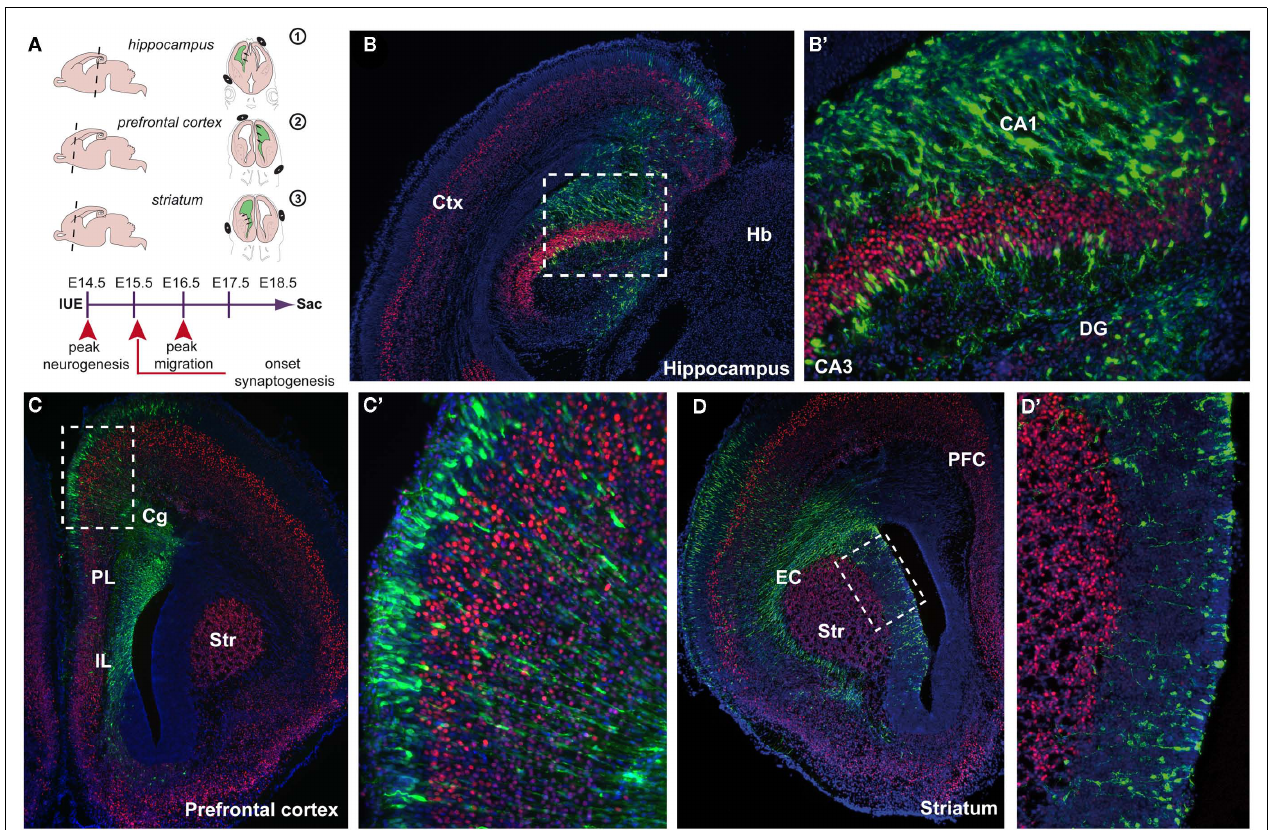
construct CMV–YFP–N1 (green) is electroporated into the hippocampal anlage enlarged in (B (cid:2) ) (boxed area), counterstained with the layerV marker Ctip2 (red) and fluorescent Nissl (blue). (C) Electroporation was performed into the whole span of the medial prefrontal cortex (mPFC) including the infralimbic (IL), prelimbic (PL), and cingulate cortex (Cg). Boxed area is enlarged in (C (cid:2) ) . (D) Electroporation was performed into the ventricular zone (VZ) of the caudate putamen (CP) close to the external capsule (EC). Boxed area is enlarged in (D (cid:2) ) . CA1, cornu ammonis 1 ; CA3, cornu ammonis 3 ; Cg, cingulate cortex; Ctx, cortex; DG, dentate gyrus; EC, external capsule; Hb, habenula; Str,